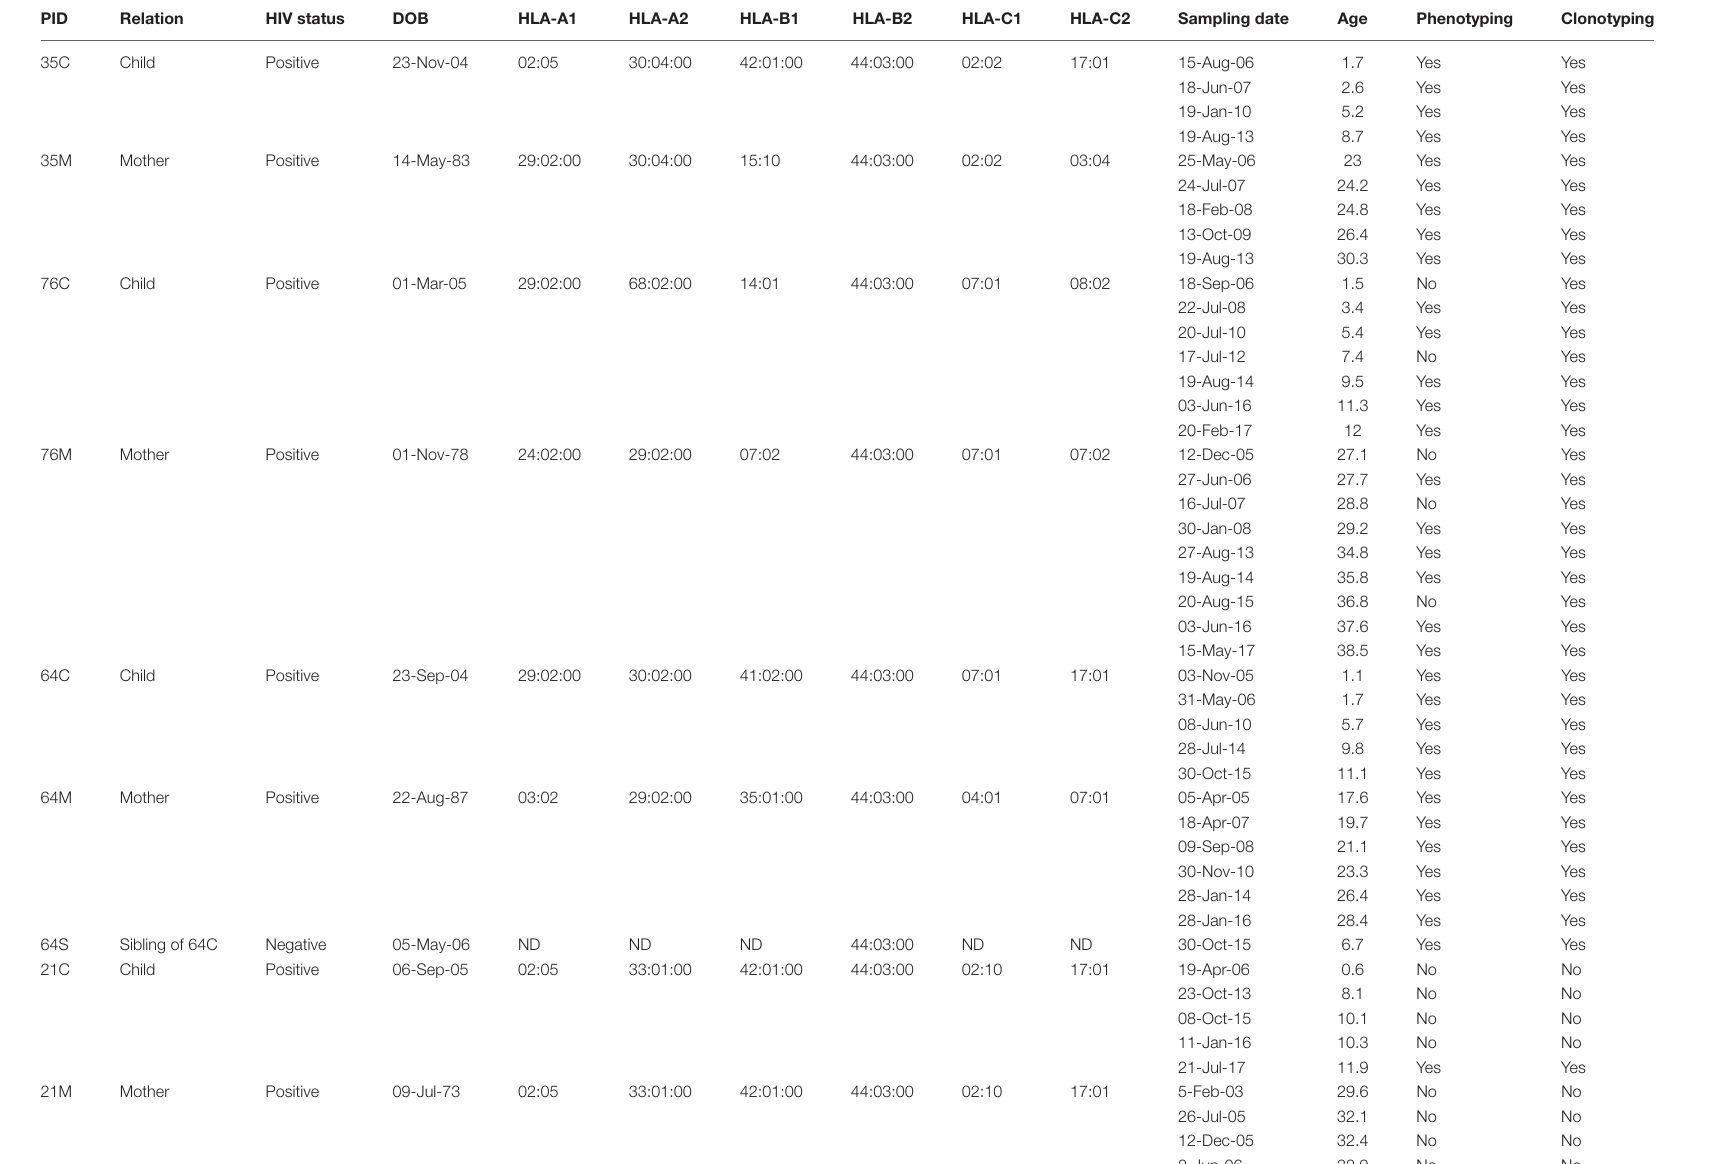
TABLE 1 | Patient characteristics.